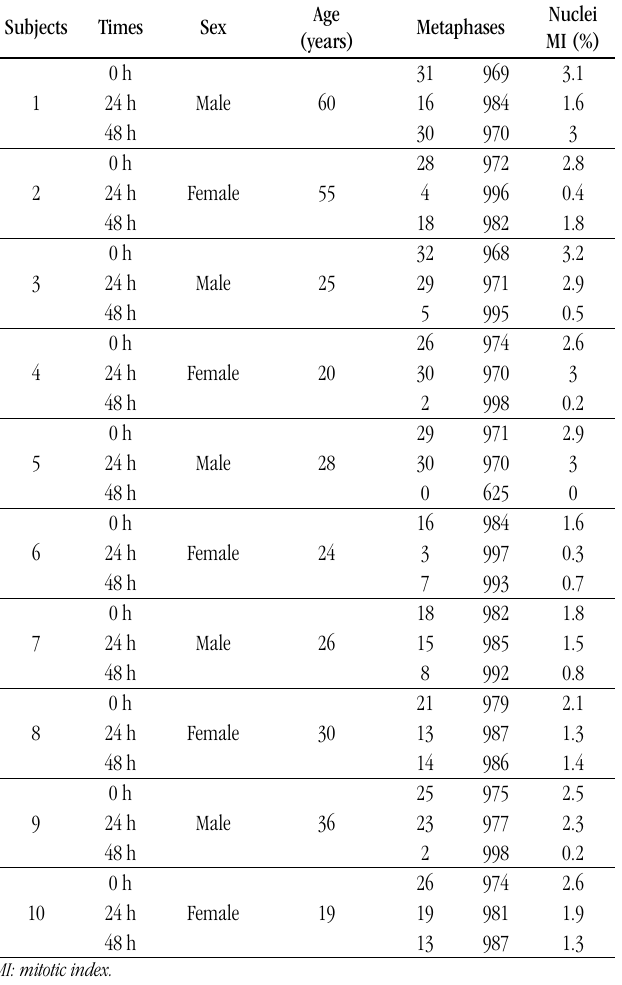
because they did not present a convenient morphological model and did not fit the analyzed patterns. Figure 3 represents the average karyotype pattern of analysis at the three observed times.